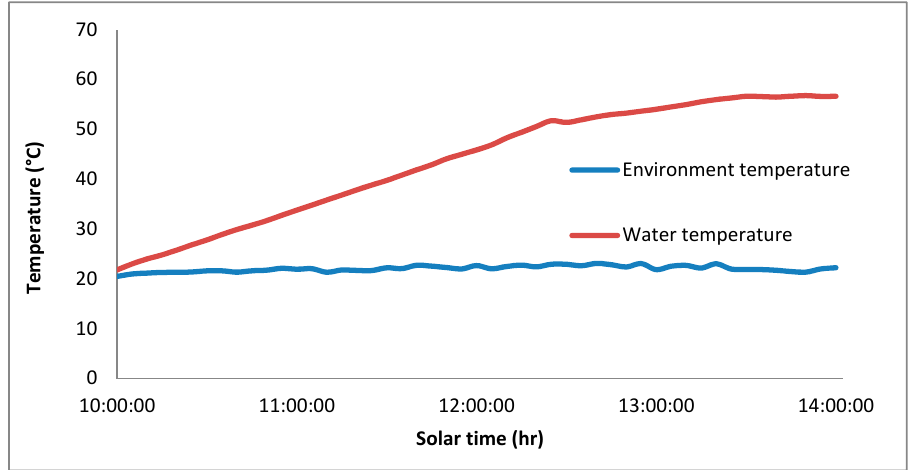
Figure 5. Water temperature in heating-water module.